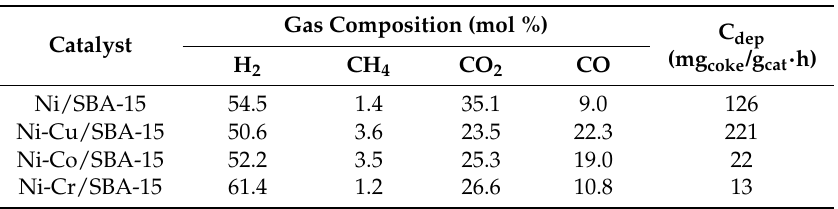
Table 2. Gas products distribution and coke formation in glycerol steam reforming using Ni-(Cu,Co,Cr)/SBA-15 catalysts ( T = 600 ◦ C, P = 1 bar, WHSV glycerol = 7.7 h − 1 ; water/glycerol = 6 mol/mol, TOS: 5